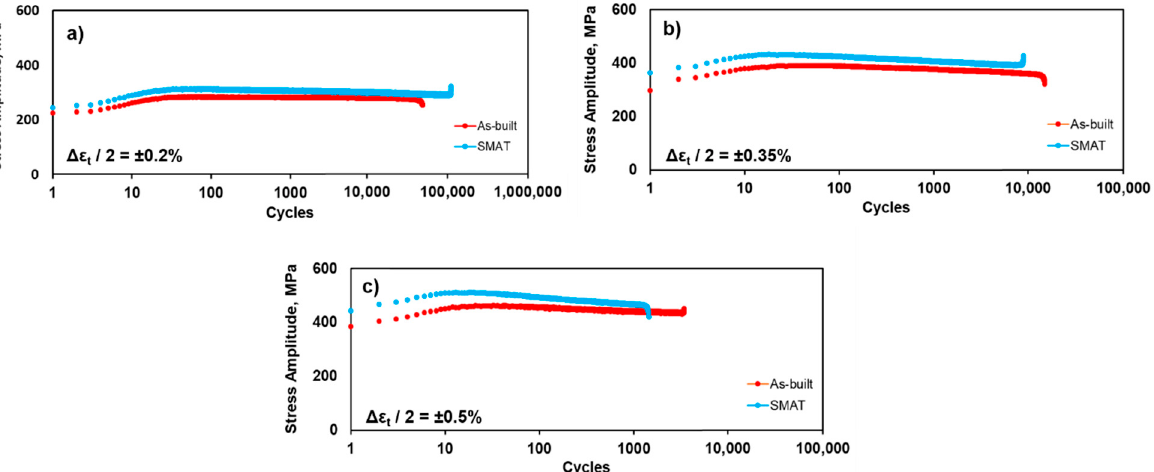
Figure 9. Cyclic stress response at room temperature at total strain amplitudes of ( a ) Δε t /2 = ±0.2%, ( b ) Δε t /2 = ±0.35% and ( c ) Δε t /2 = ±0.5% for the DED SS 316L in as-built and SMAT processed condition.